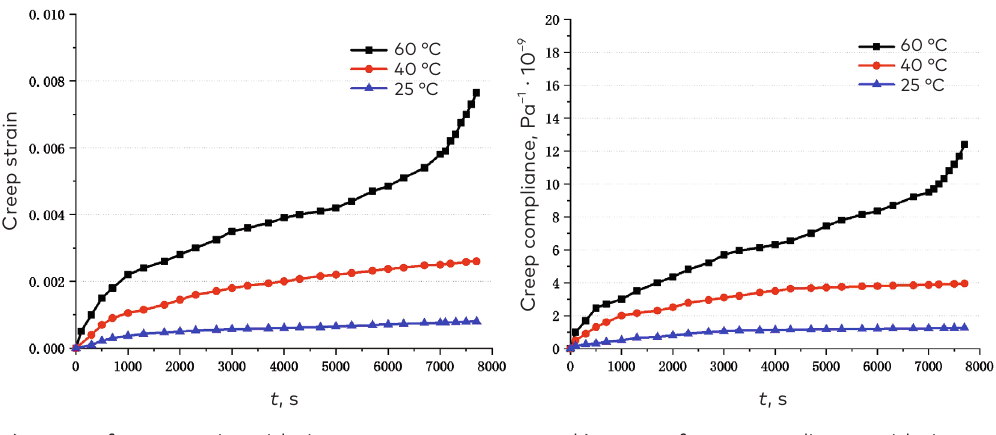
b) curves of creep compliances with timea) curves of creep strains with